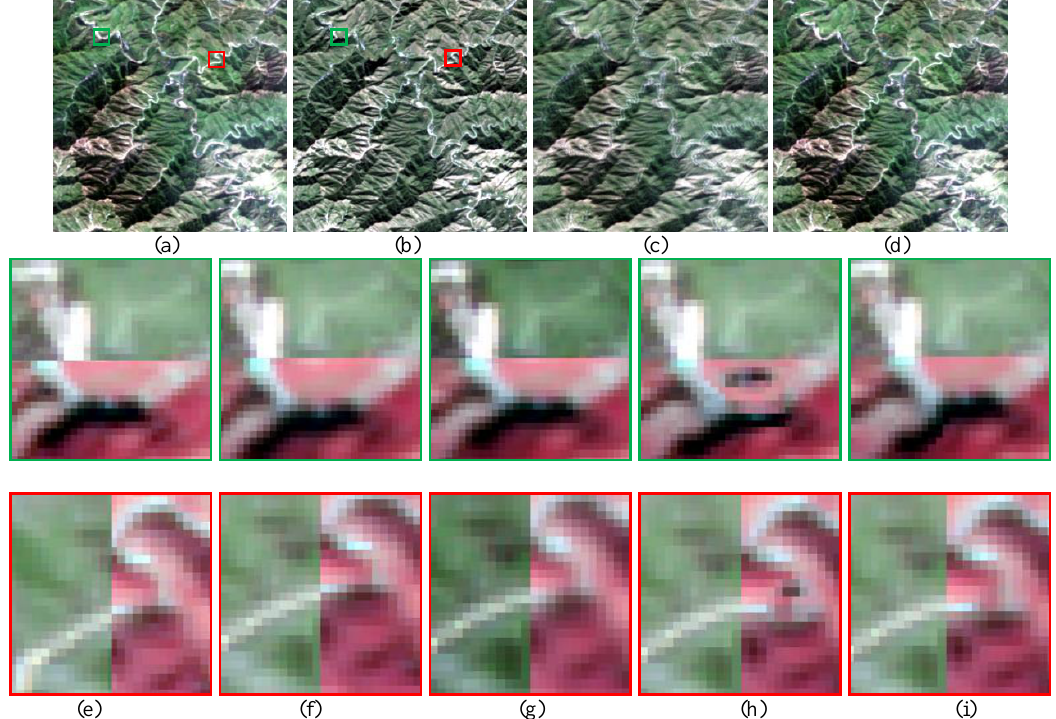
Figure 5. The second experiment. (a) Reference image. (b) Sensed image. (c) Overlapping of the original images. (d) Overlapping of the reference and aligned image from the proposed method. Magnified images of selected area marked in red and green rectangles from (e) the original images, (f) PLM (Goshtasby 1986), (g) BWP (Feng et al. 2017), (h) optical flow without post-processing (Brox et al. 2004),and (i) the proposed method